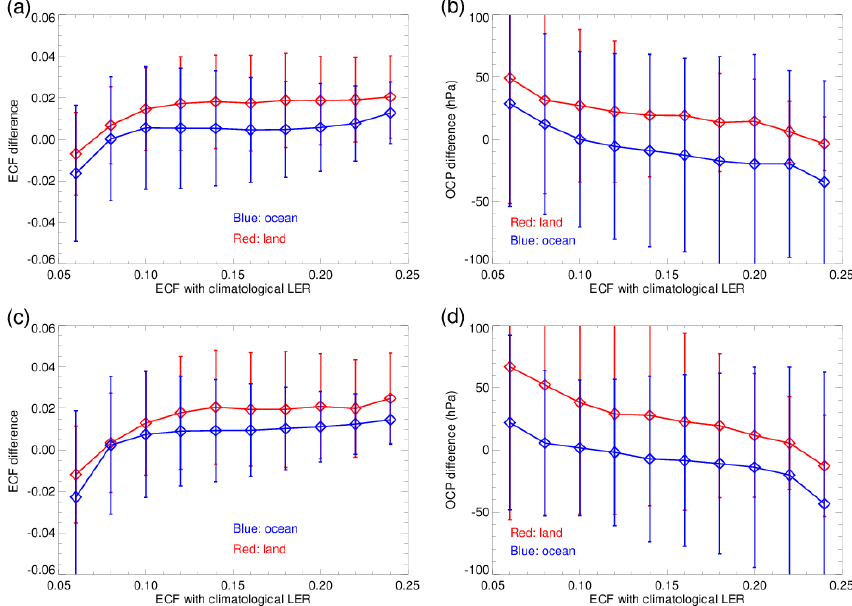
Figure 11. Comparison of O 2 –O 2 -derived ECFs and OCPs computed with geometry-dependent and climatological LERs; data are for 0 . 05 < ECF < 0 . 25. (a) The mean ECF difference and (b) OCP difference (diamonds) and standard deviation (error bars) as a function of ECF for 14 July 2006; (c) the mean ECF difference and (d) OCP difference (diamonds) and standard deviation (error bars) as a function of ECF for 14 November